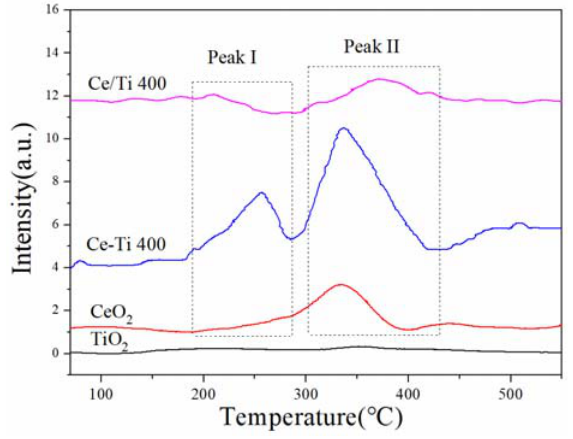
Figure 6. NO-TPD profiles of Ce-Ti-400 and Ce/Ti-400.